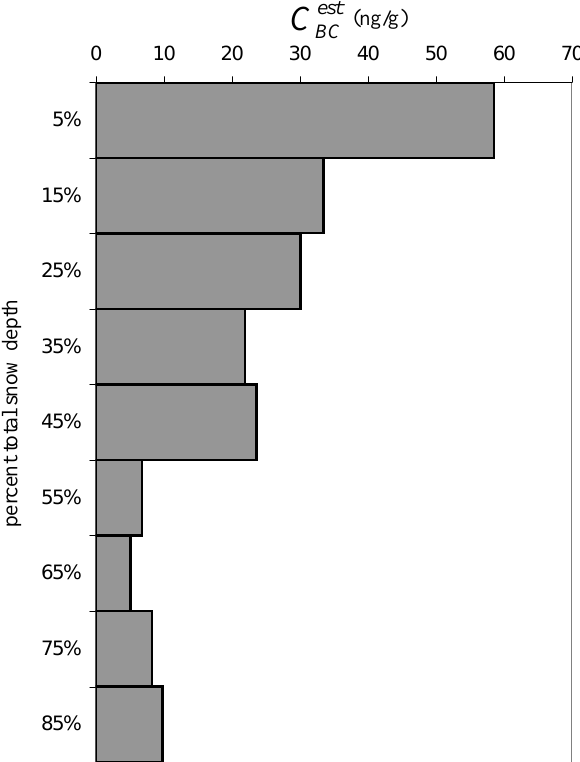
Fig. 11. A profile of BC concentrations in the snowpack in Cher- skiy, Russia. The higher values at the surface are indicative of BC concentration at the snow surface with sublimation, and/or dry de- position of BC during winter and spring. The low concentrations in the lower part of the snowpack may be affected by self-cleaning in depth hoar (see